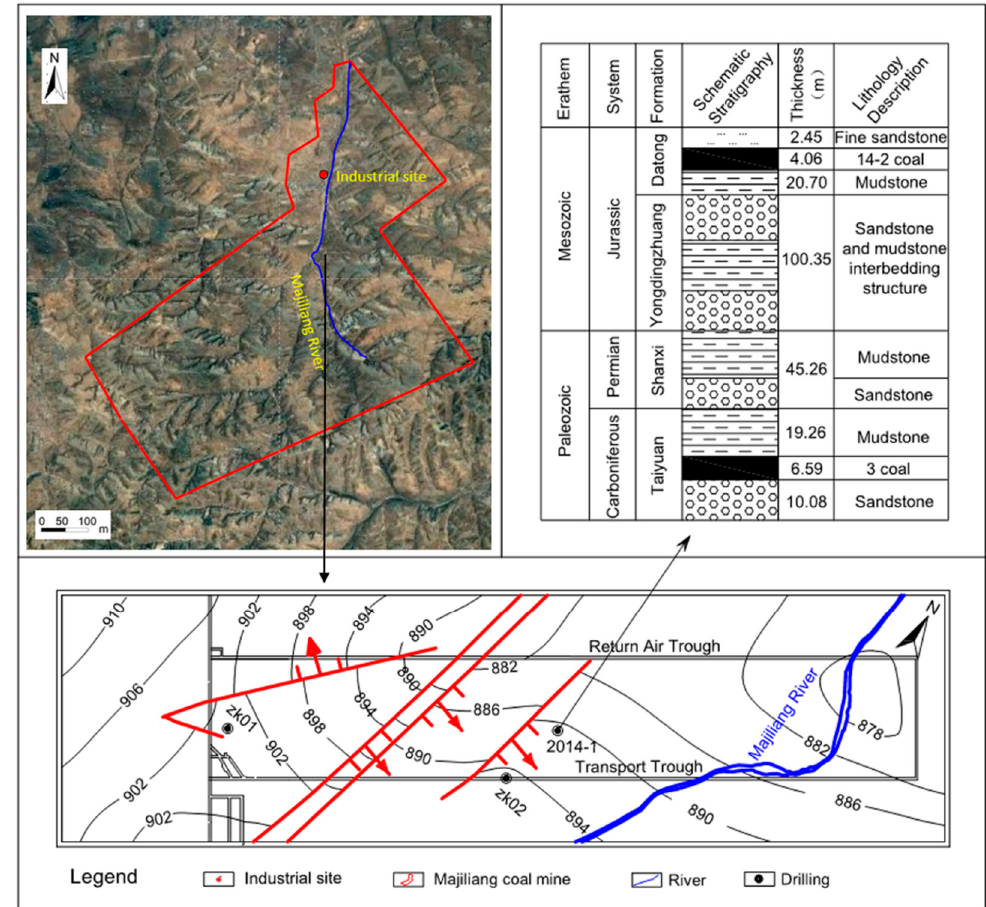
Figure 2. Location of Majiliang Coal Mine and general situation of working face 8117.